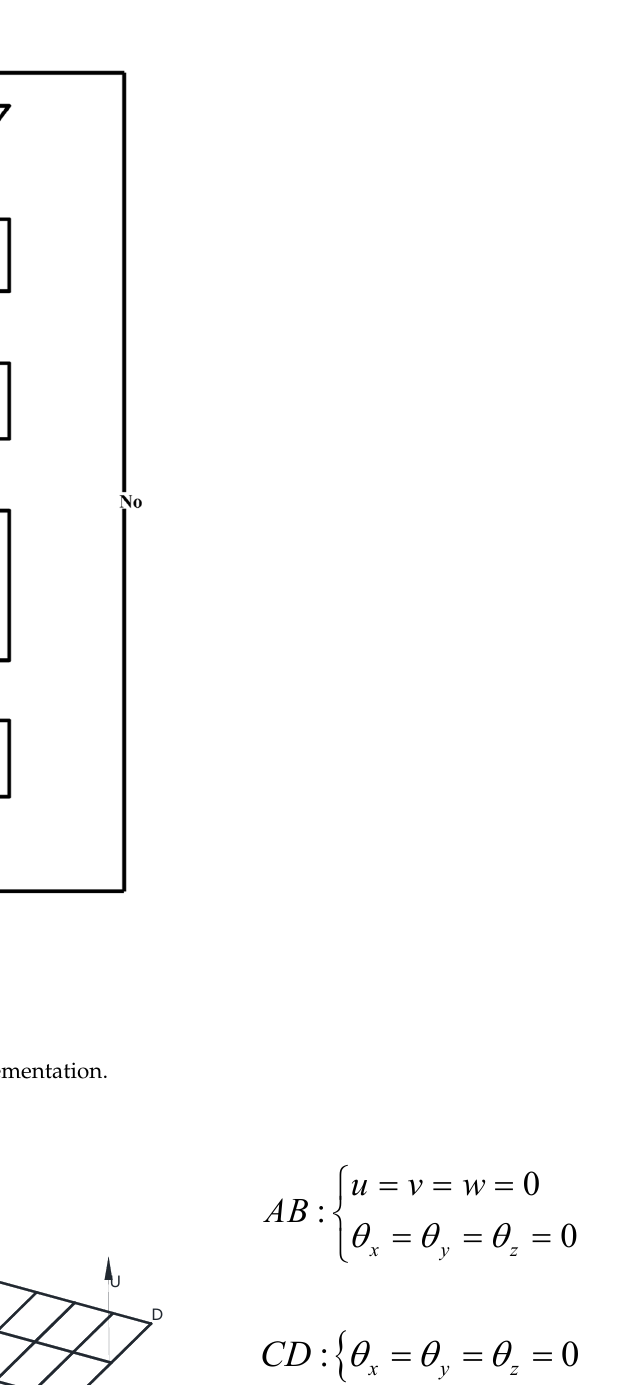
A numerical sensitivity analysis was carried out on the PA66GF20 sample with a